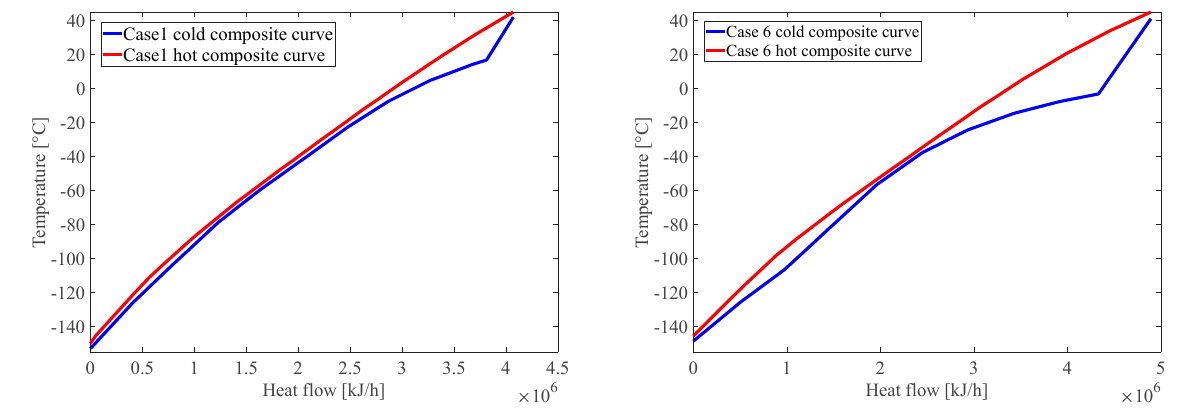
Figure 5. Heat curve of case 1 ( left ) and case 6 ( right ).